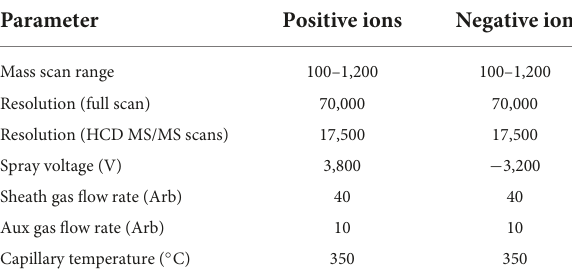
TABLE 2 Mass spectrometry